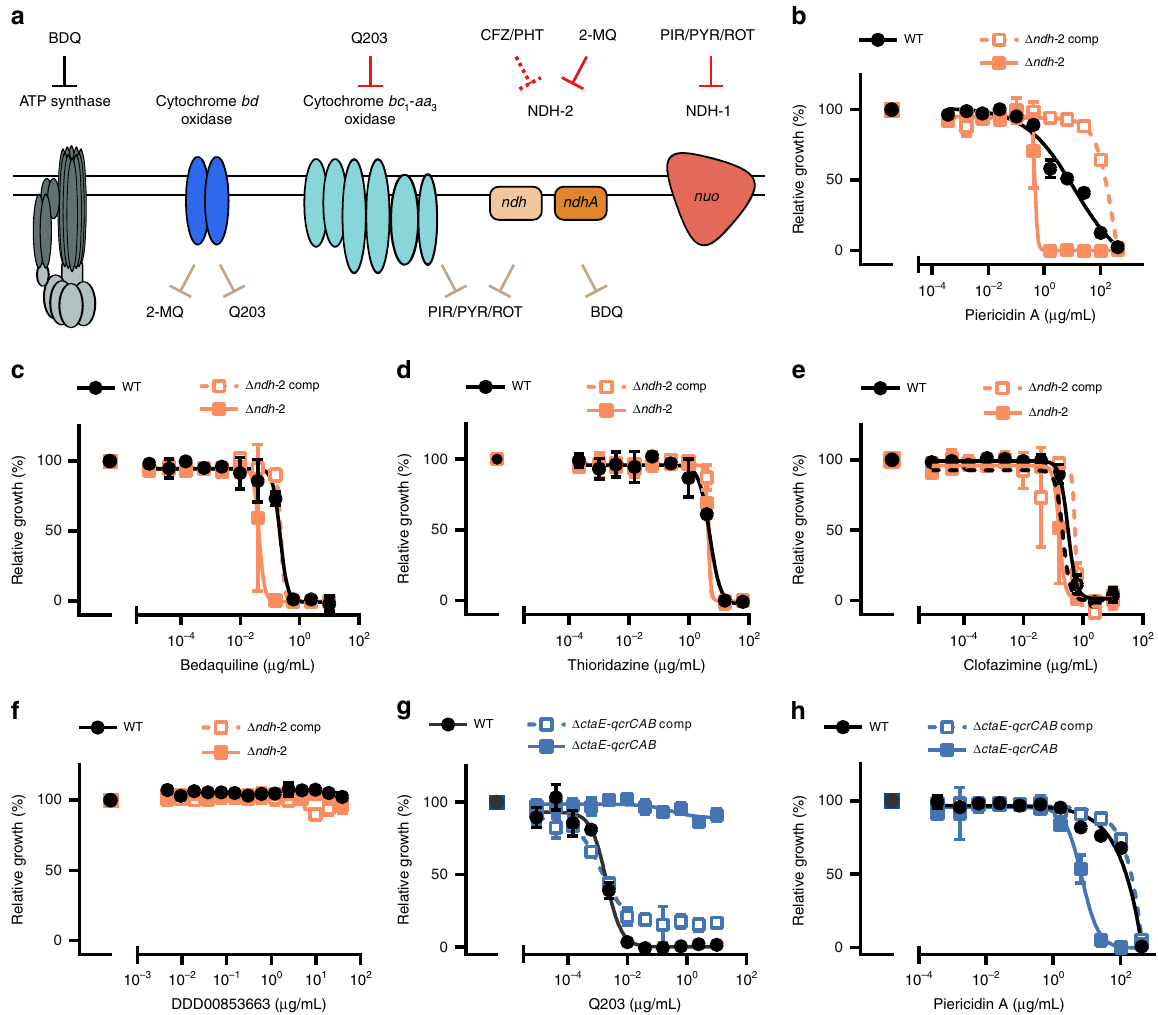
Fig. 6 Chemical – genetic interactions. a Summary of chemical – genetic interactions. Red lines represent direct interactions that are consistent (solid red lines) or inconsistent (dotted red lines) with the chemical – genetic interactions de fi ned in this study. Brown lines represent chemical – genetic interactions that have been de fi ned in this study and are most likely indirect. Impact of piericidin A ( b , h ) bedaquiline ( c ) thioridazine ( d ), clofazimine ( e ), DDD00853663 ( f ), and Q203 ( g ) on growth. Data are averages of three cultures and represent at least two independent experiments. Error bars correspond to standard deviation. BDQ, bedaquiline; CFZ, clofazimine; PHT, phenothiazines; PIR, piericidin A; PYR, pyridaben; ROT, rotenone; 2-MQ, 2- mercapto-quinazolinones. “ Comp ” stands for complemented. Source data are provided as a Source Data fi